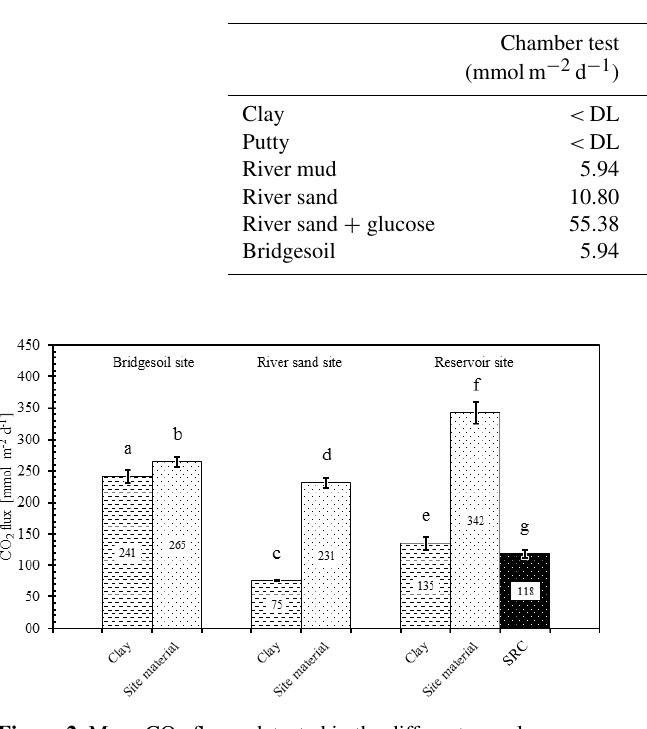
Table 2. Performance of different sealing materials in lab experiments (mean ± SD). Number in brackets indicates number of replicates below the detection limit (DL); n = 3 except for river mud ( n = 4) and river sand + glucose ( n = 6). Chamber test: chamber on paving slab, final flux in long-term experiment (Fig. 1). Chamber low CO 2 : chamber on paving slab gassed with N 2 prior to measurement. CO 2 production: sealing material in glass vessel.